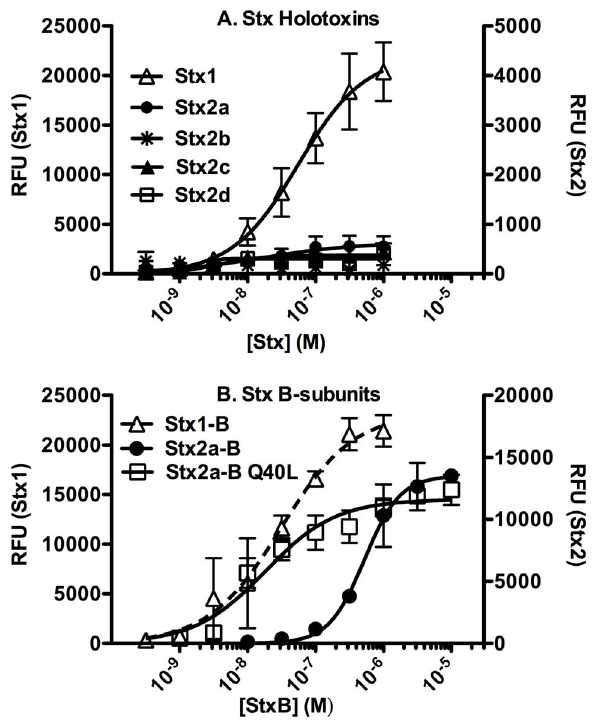
Figure 5. Binding of holotoxin and B-subunits to Lyso-Gb3. ELISA was used to study binding of serial dilutions of A. Stx holotoxins and B. B-subunits . Binding was assessed as described in Figure 2. The RFU signal is the mean of three independent experiments and error bars indicate SD.